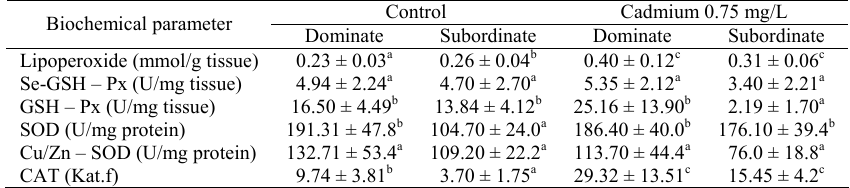
Table 2. Effect of cadmium exposure (CdCl ) on oxidative stress markers in liver of Nile tilapia. Mean (±SD) values that do not 2 share the same letter for each parameter are statistically different (P <